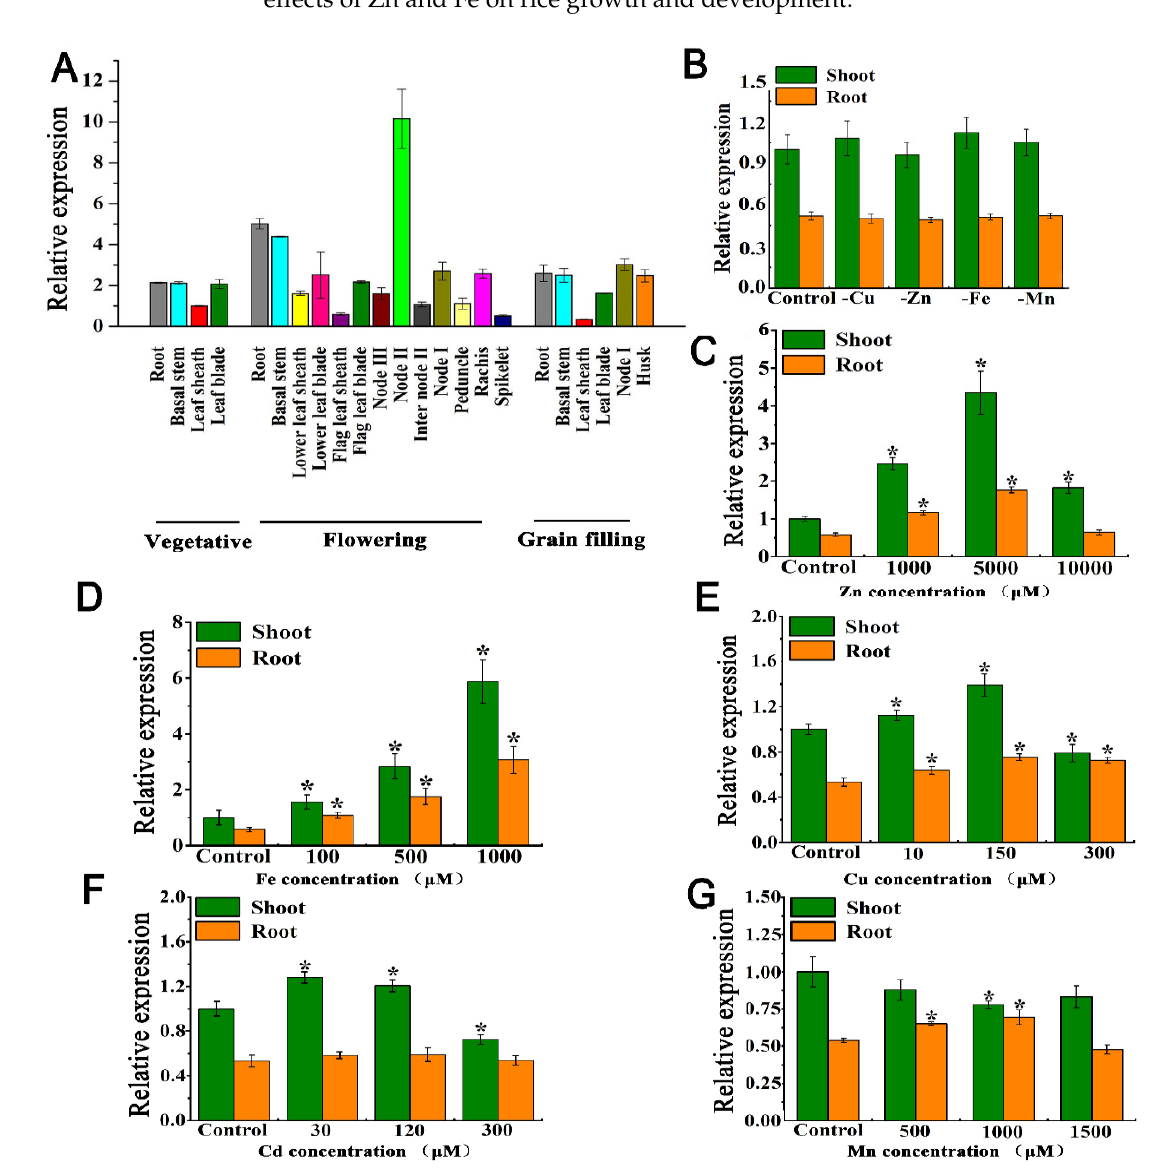
Figure 1. Transcriptional expression of OsHIPP33 in rice (Nipponbare) under normal and metal stress conditions. ( A ) OsHIPP33 expression in diverse tissues at different development stages. ( B ) Response of OsHIPP33 to metal deficiency. Ten-day-old rice was grown in a nutrient solution with (control) or without Zn, Fe, Mn or Cu for 2 weeks. ( C – G ) Two-week-old rice was grown in the nutrient solutions with 1, 5 and 10 mM Zn; 0.1, 0.5 and 1 mM Fe; 10, 150 and 300 µ M Cu; 30, 120 and 300 µ M Cd; and 0.5, 1 and 1.5 mM Mn for 6 h. Results indicate the means of biological triplicates. Asterisks indicate the significant difference between the treatments and control ( p <